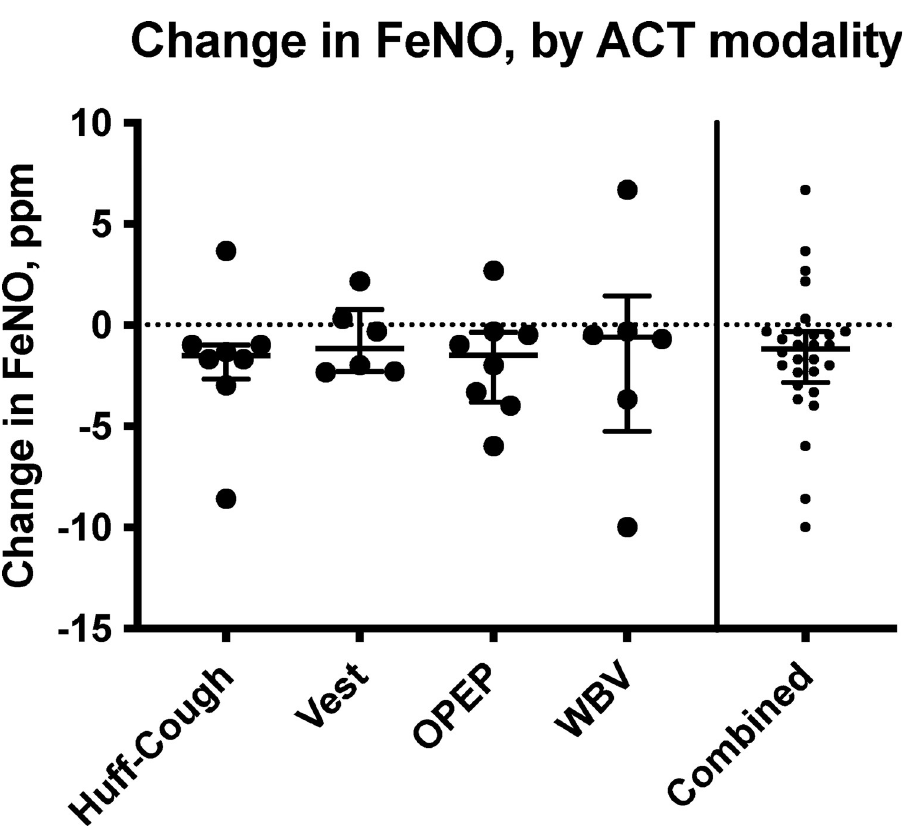
Fig 3. Change in FeNO following ACT. Median values and interquartile range are demarcated. Each ACT method showed an average decrease in FeNO following ACT, but this did not reach statistical significance until all values were pooled (p = 0.006, Wilcoxon signed-rank